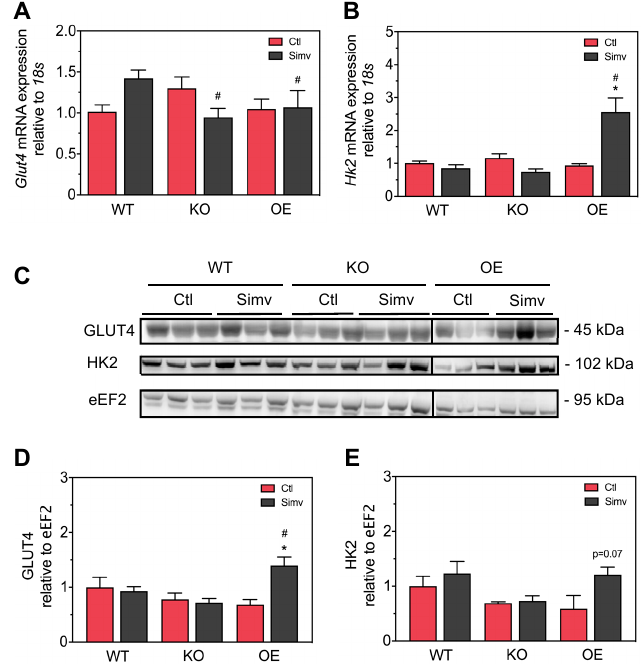
Figure 5. mRNA and protein expression of Glut4 and hexokinase. Intensity of the protein bands acquired from quadriceps muscle homogenates was quantified by normalizing them to eEF2 expression. The mRNA expression of Glut4 ( A ) and Hk2 ( B ). Western blots showing protein expression of Glut4, HK2, and eEF2 ( C ). Quantification of Glut4 ( D ) and HK2 ( E ) protein expression normalized to eEF2. After two-way ANOVA analysis, the treatment factor was significant in ( B , D ), the animal model factor significant in ( A , B , D ) and the interaction between treatment and animal model significant in ( A , B , D ). Data are presented as mean ± SEM of 3–7 randomly chosen animals per group. * p < 0.05 between simvastatin-treated and respective control mice and # p < 0.05 between KO or OE and WT mice within the same treatment group. Ctl, control; KO, PGC-1 α knock-out mice; OE, PGC-1 α overexpressing mice; Simv, simvastatin; WT, wild-type.